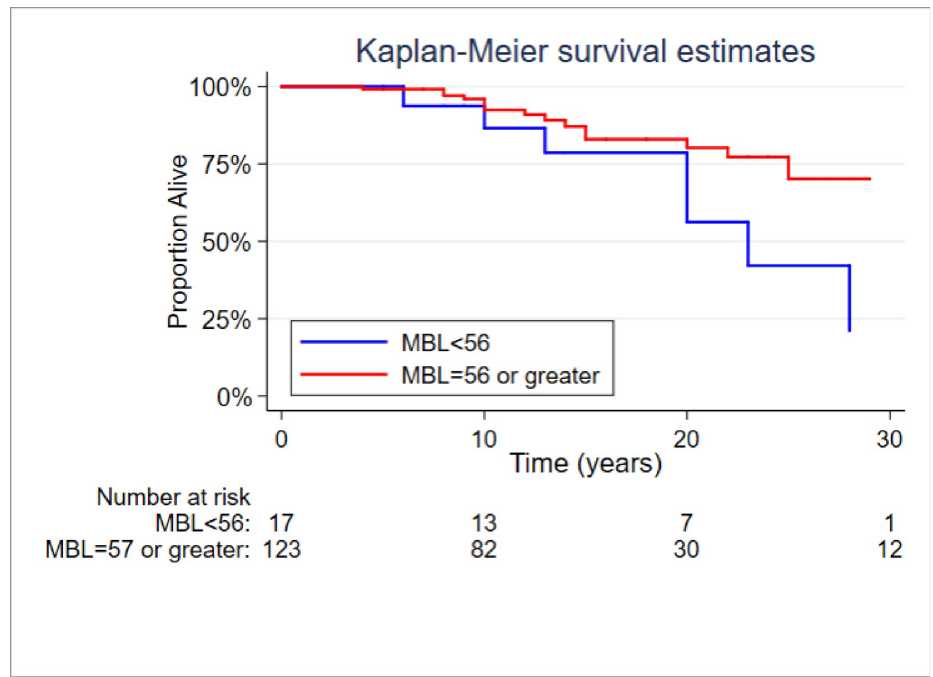
Fig 3. Kaplan–Meier survival curves indicating survival according to MBL